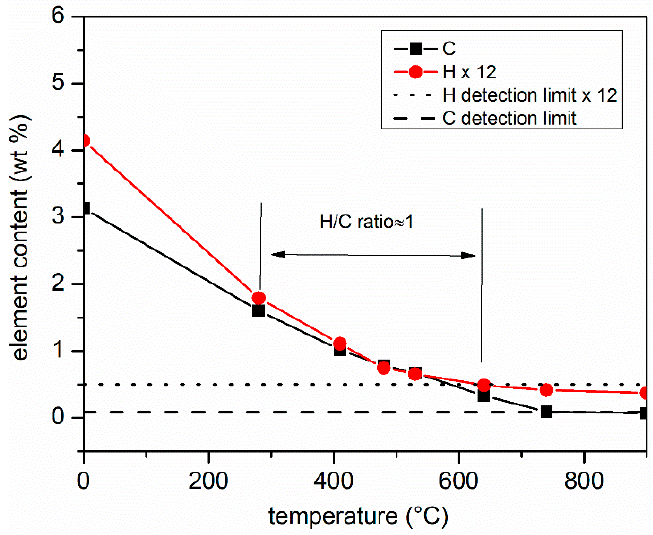
Figure 3. Carbon and hydrogen contents (wt%) of sample NA − C − T (T = 280, 400, 480, 530, 640, 740, and 900 ◦ C) and sample NA − C (T = 0).